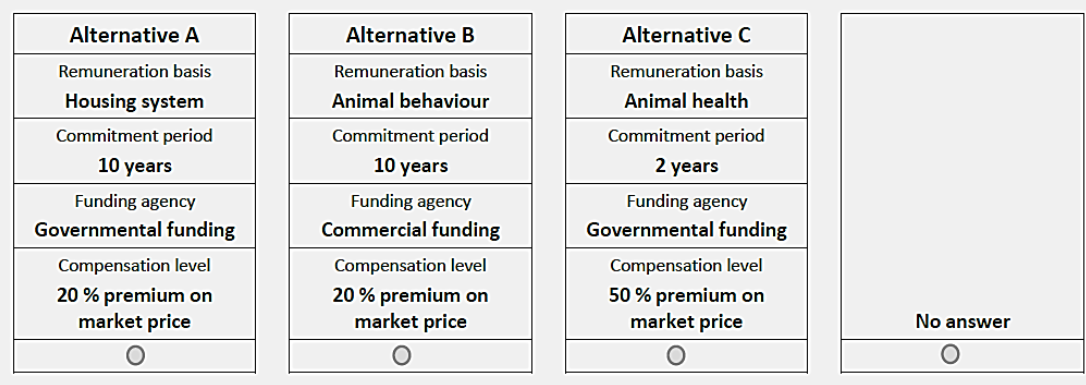
Figure 1. Example of a choice set.